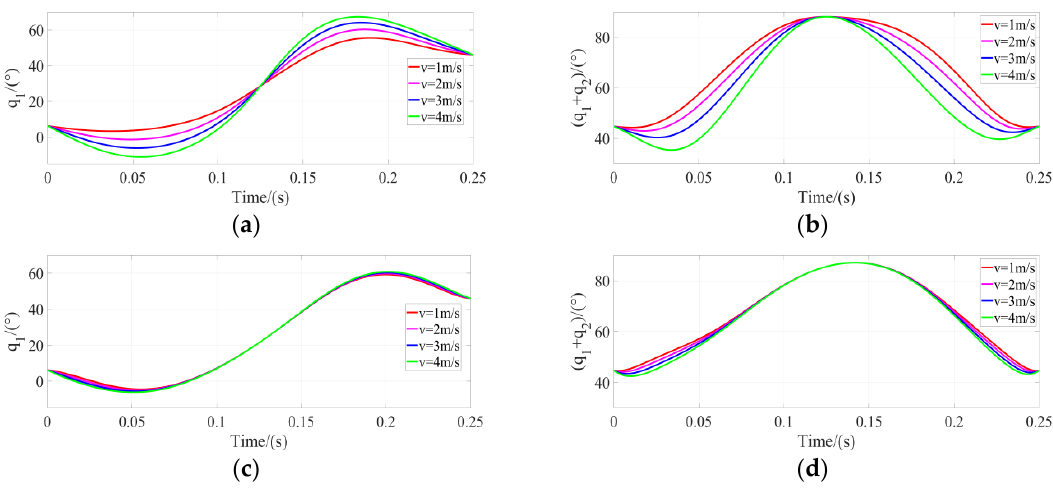
Figure 14. The motor rotation angle calculated by MATLAB during the swing phase: ( a ) The shoulder motor rotation angle in the spline curve trajectory, ( b ) the knee motor rotation angle in the spline curve trajectory, ( c ) the shoulder motor rotation angle in the Bézier curve trajectory, and ( d ) the knee motor rotation angle in the Bézier curve trajectory.